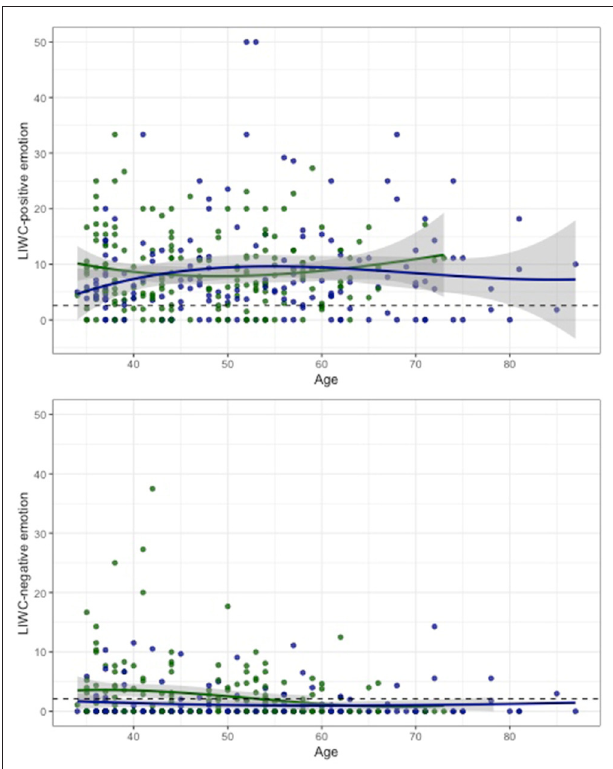
FIGURE 3 | Percent of words classified as LIWC negative and positive emotion by age with cubic splines and confidence intervals (gray shaded areas). The overall mean from expressive writing is included as a reference line